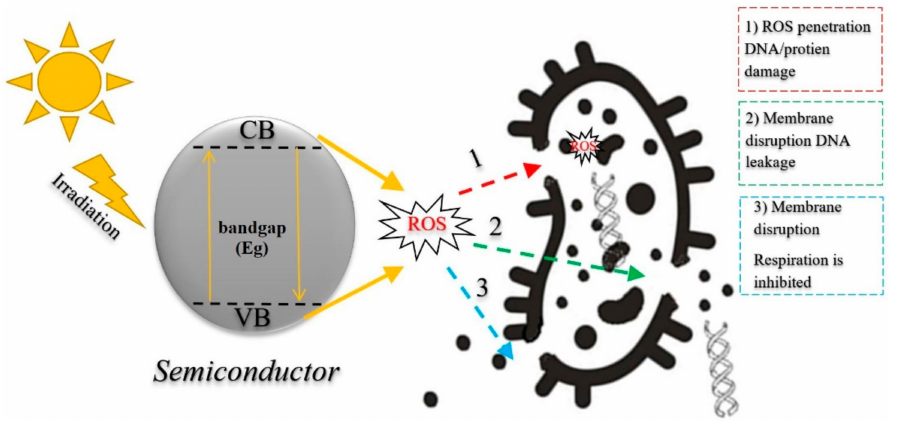
Figure 2. Proposed photocatalytic water disinfection